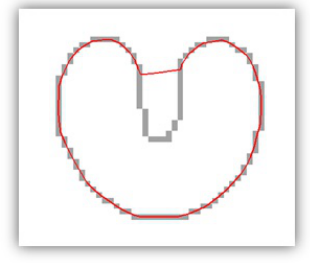
Figure 3. Parametric active contour model applied to an object with a concave boundary [21].